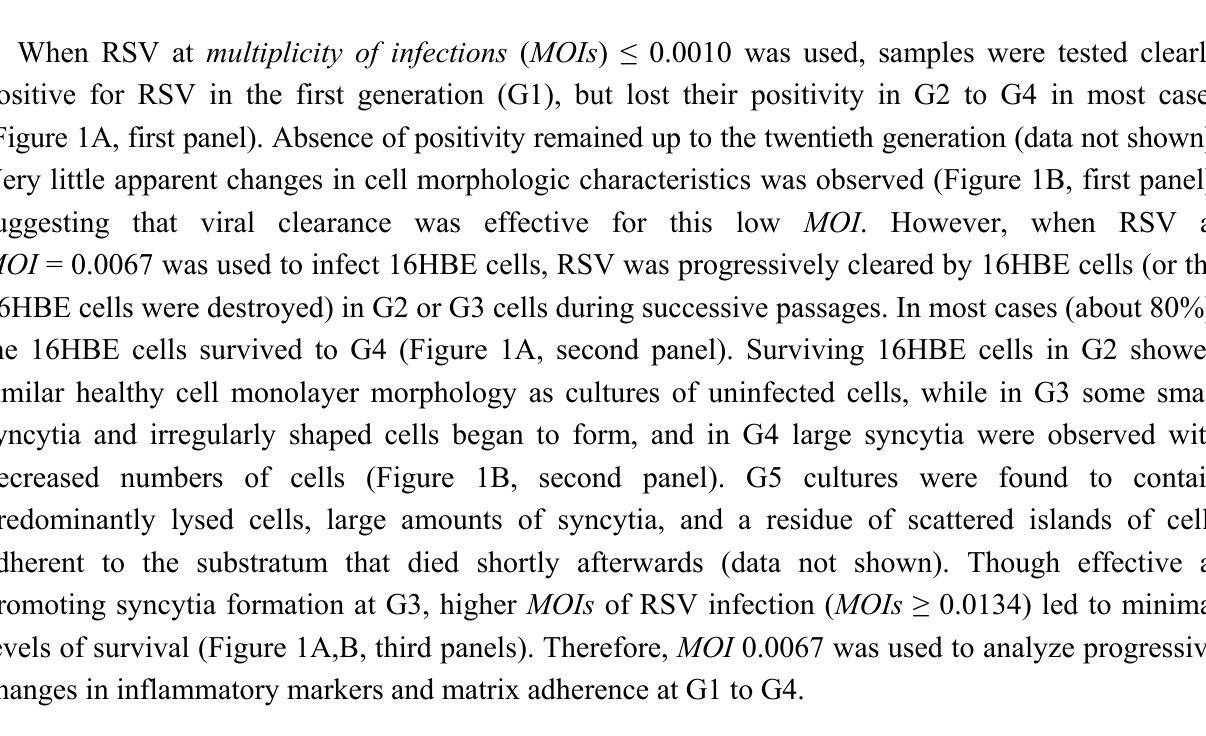
Figure 1. Effects of multiplicity of infection (MOI) on respiratory syncytial virus (RSV) RNA expression and the amount of syncytial cells in surviving human bronchial epithelial (16HBE) cells during successive passages. The box for each generation represents the interquartile range (25th–75th percentile) and the line within this box is the median value. Bottom and top bars of the whisker indicate the 10th and 90th percentiles, respectively. Outlier values are indicated (dot). ( A ) RSV RNA levels; and ( B ) the amount of syncytial cells in surviving RSV-infected 16HBE cells ( MOIs ≤ 0.0010, MOI = 0.0067 or MOIs ≥ 0.0134) from the first generation (G1) to the fourth generation (G4). Symbols signify statistical significance, where * p < 0.05, ** p < 0.01, and *** p < 0.001 compared with